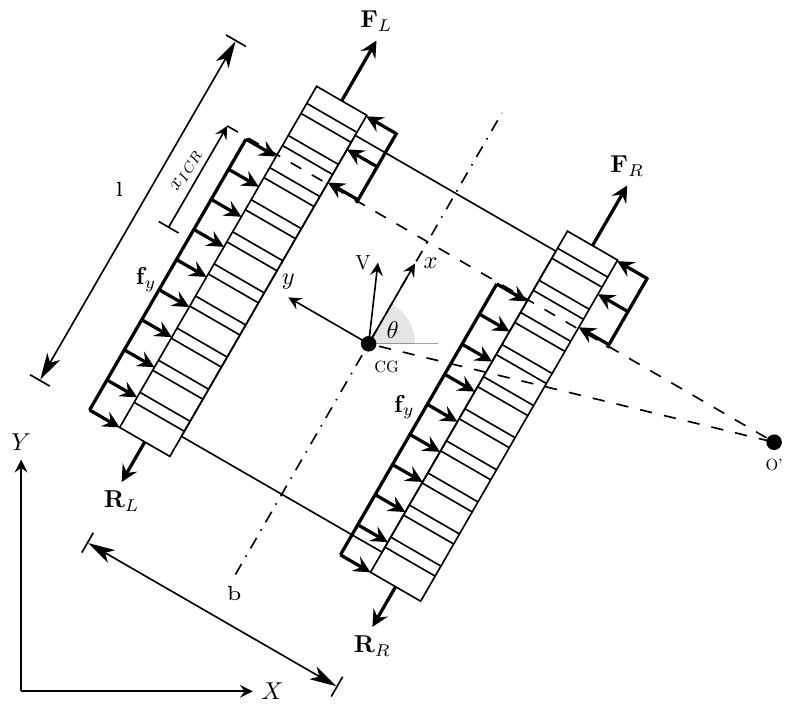
Figure 5. Free-body